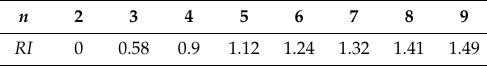
Table 6. Random inconsistency indices